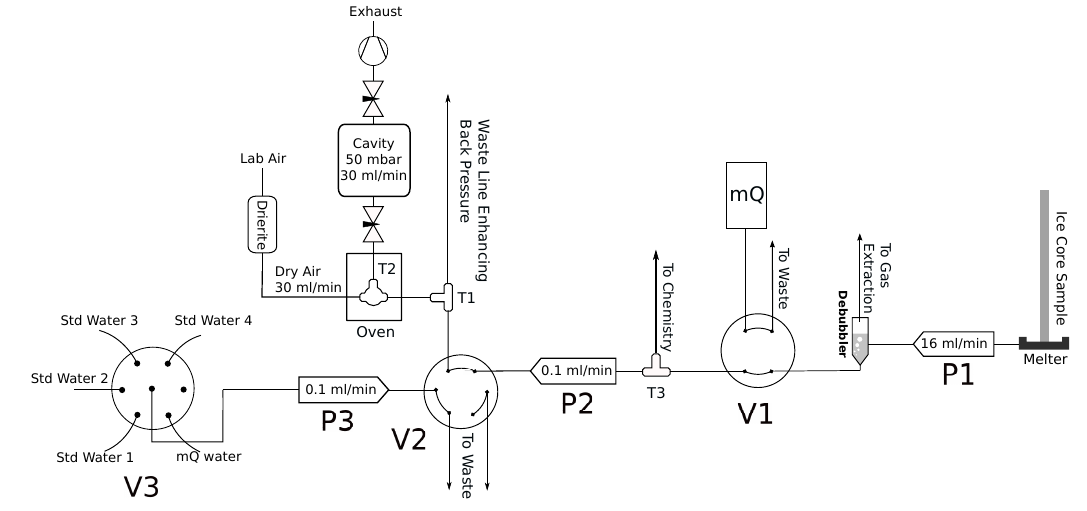
Fig. 1. Block diagram of the CFA-CRDS system.